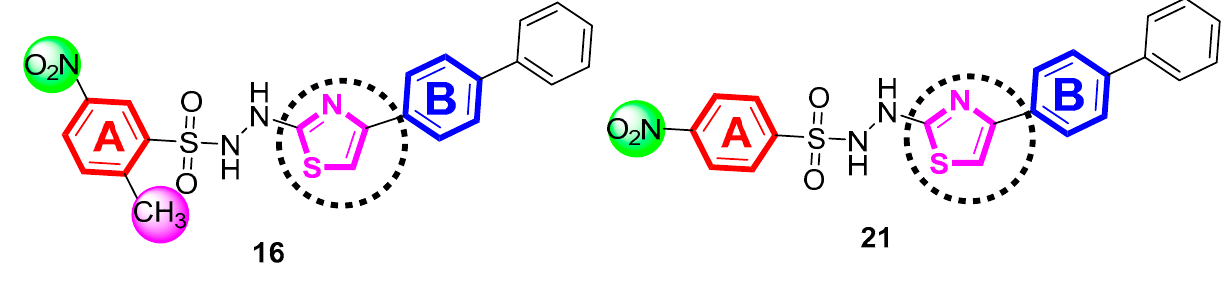
Figure 7. SAR study for scaffolds 16 and 21 .